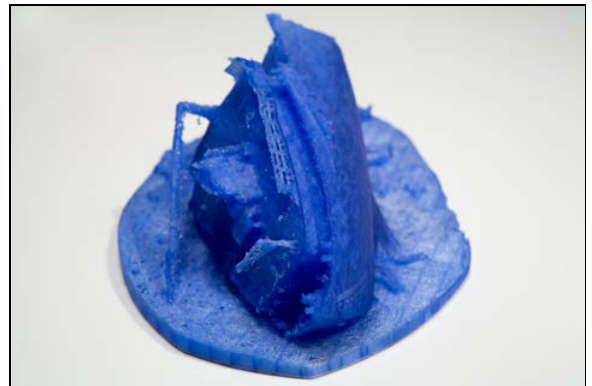
Figure 6. Printed model on ABS thermoplastic